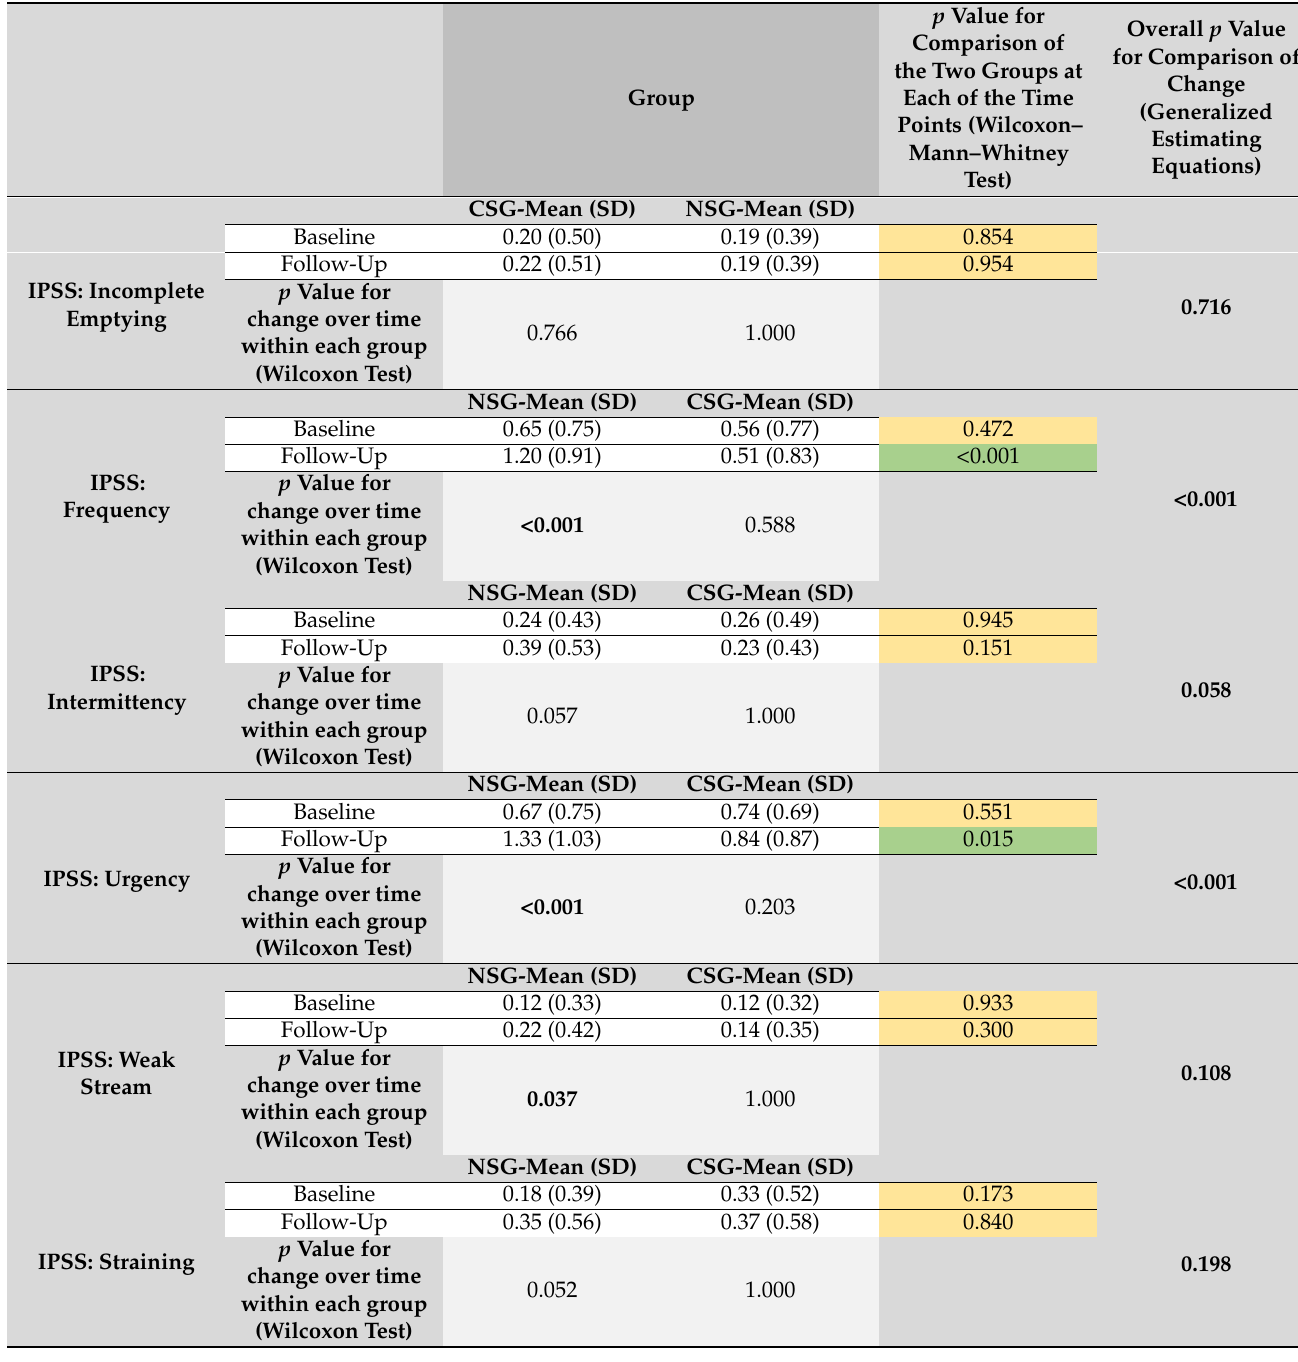
Table 1. Comparison of the two groups in terms of change in IPSS (n = 92).